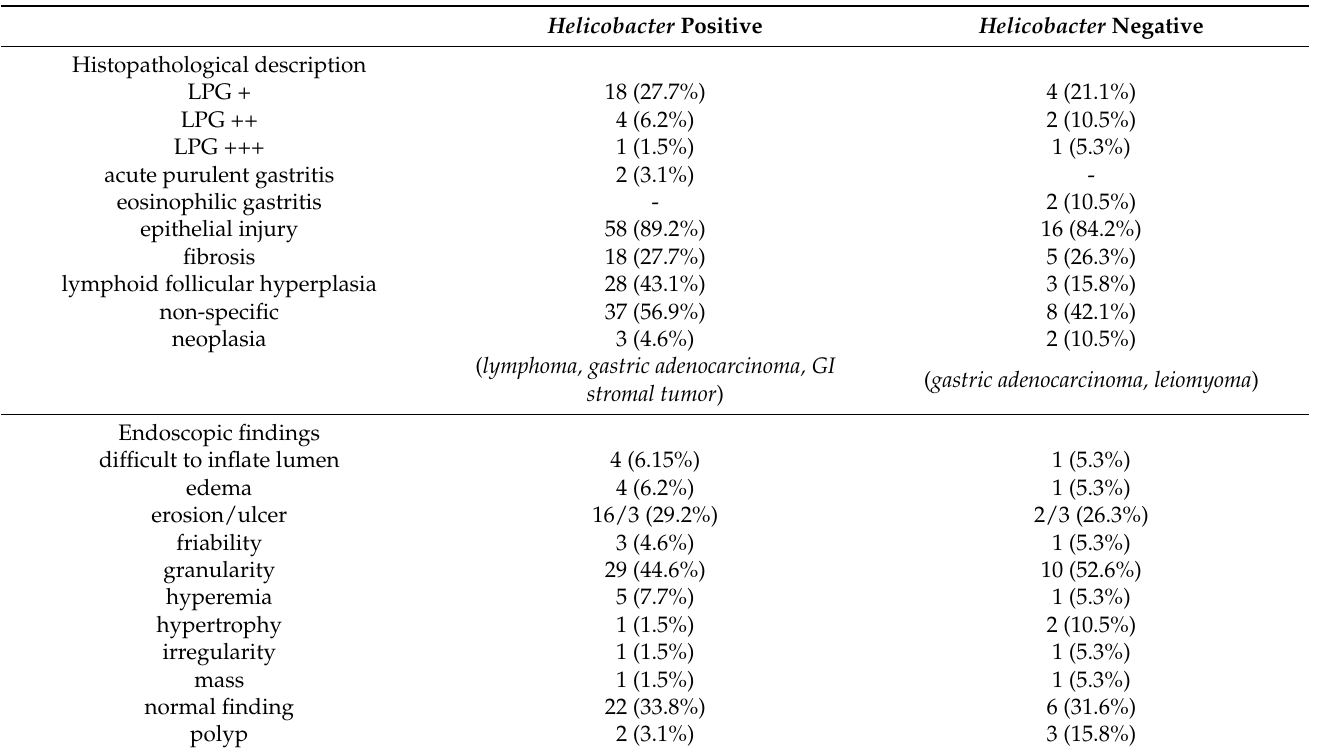
Table 6. Results of histopathology and endoscopic findings in 65 Helicobacter positive dogs (us- ing a combination of diagnostic tests for Helicobacter spp. including rapid urease test, cytology, histopathology, and PCR) and 19 dogs negative for Helicobacter